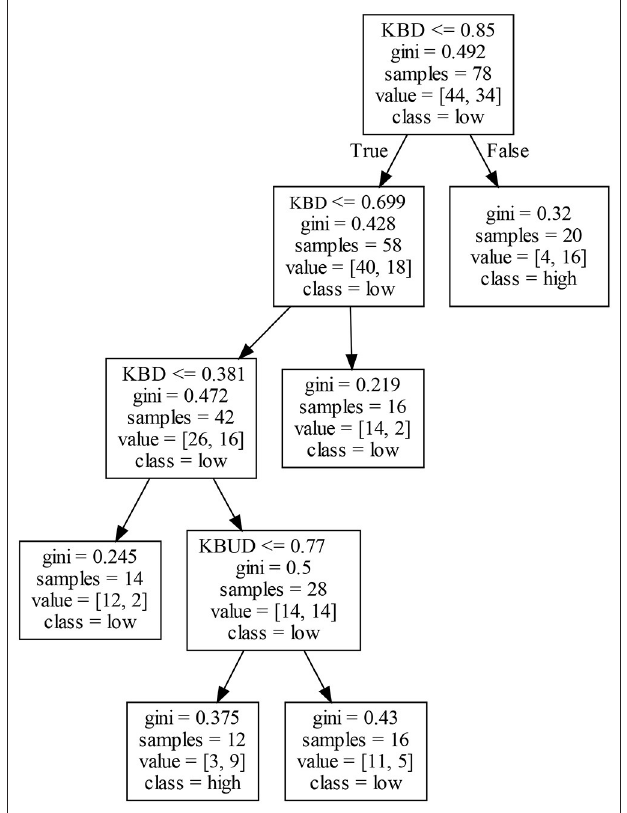
FIGURE 6 | Decision tree for EIP1 in Cluster III.